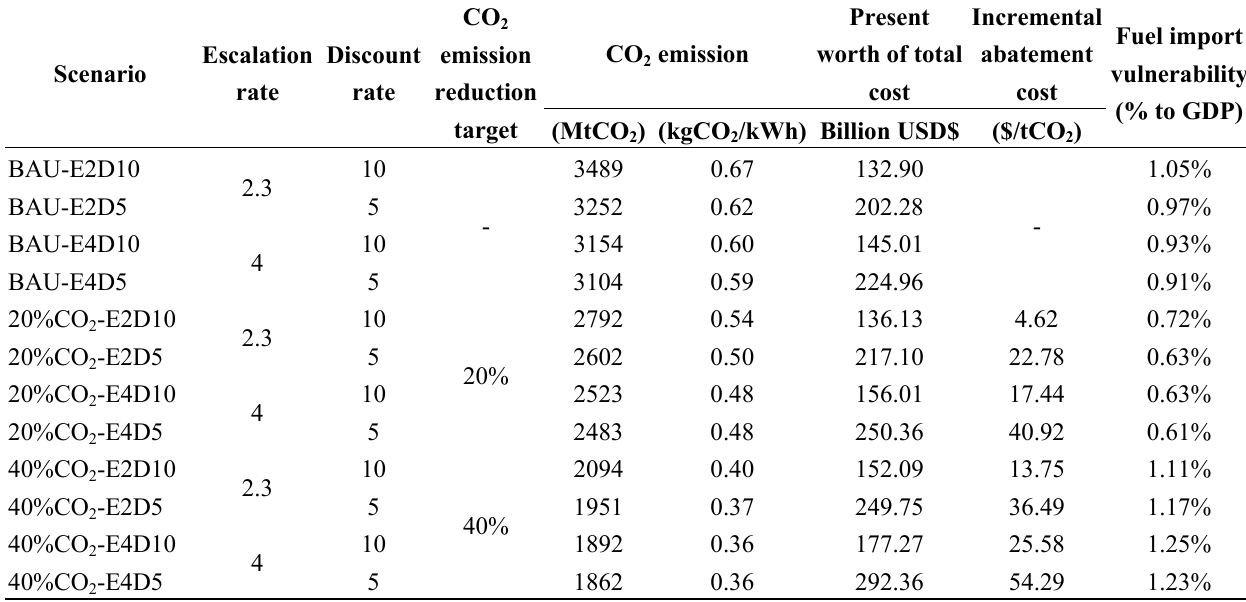
Table 8. Economic and environmental results of the sensitivity